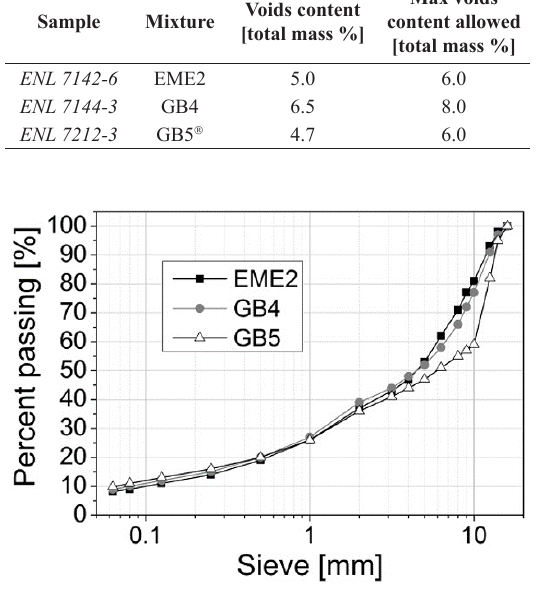
Figure 3. Grading curve of the tested mixtures.